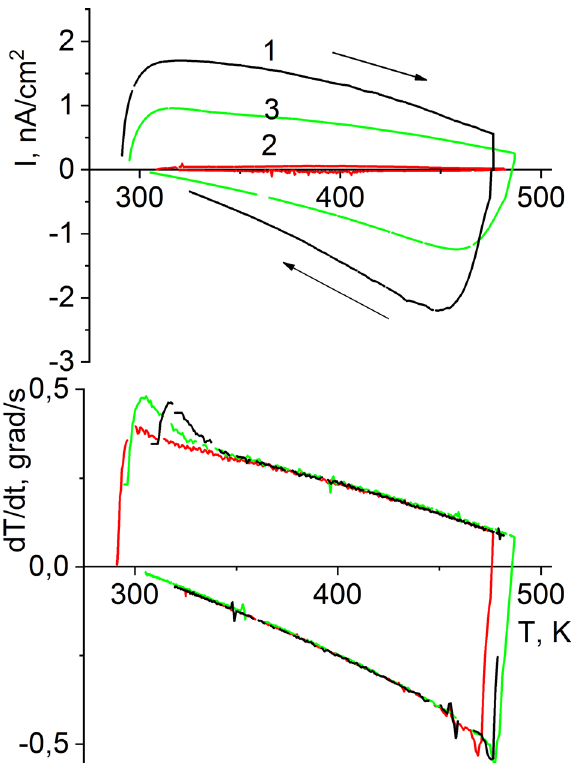
Figure 9. Temperature dependences of currents of thermally stimulated depolarization (TSDC) and heating rate of hot-pressed BTN cuts 1, 2, and 3.